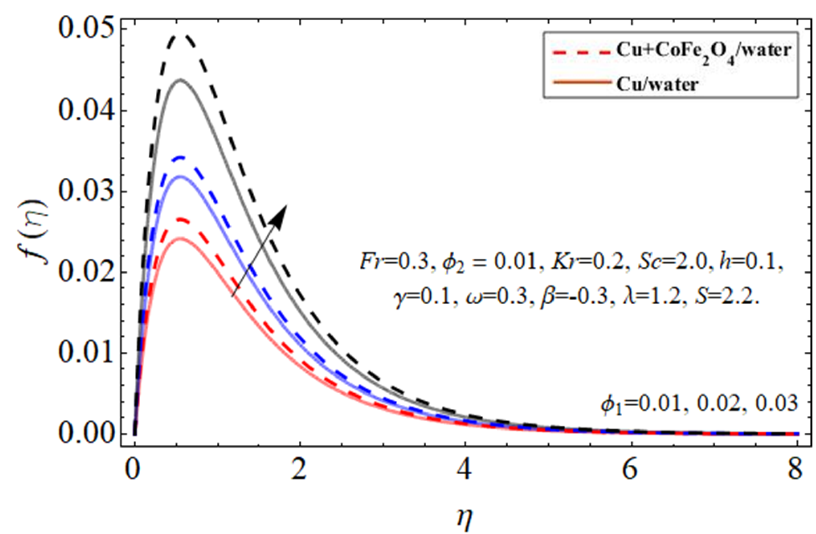
Micromachines 2023 , 14 , 48 8 of 16